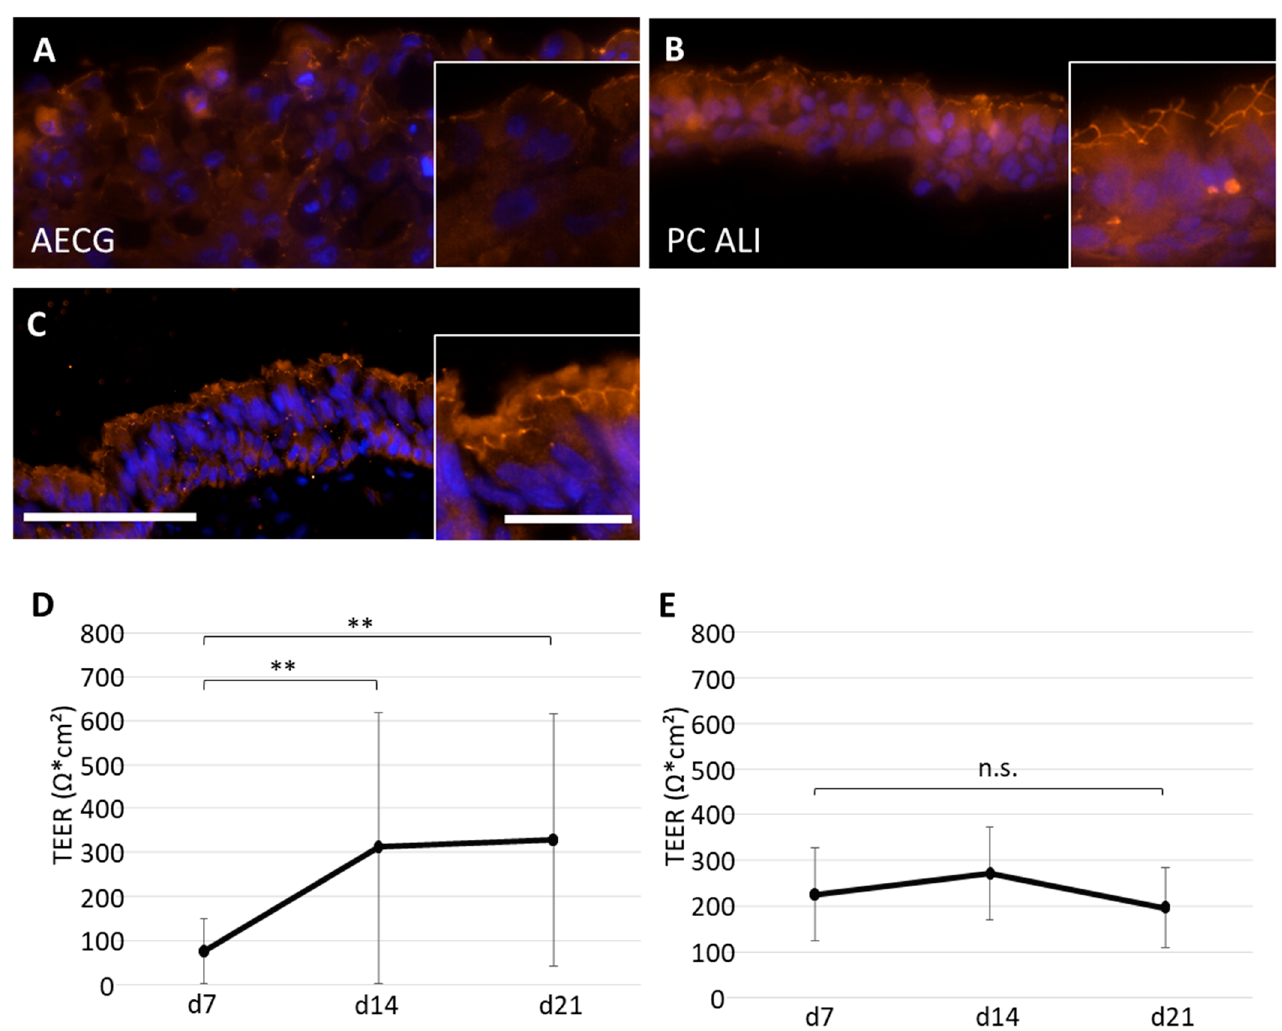
Figure 6. Formation of tight junctions and transepithelial electrical resistance (TEER) measurements in 3D airway tissue models. ( A – C ) Immunofluorescence stainings against zonula occludens (ZO-1, orange) on cross sections of 21 days old ALI models cultivated with AECG (n = 9 from four donors) ( A ) and PC ALI medium (n = 6 from four donors) ( B ), and of native bronchus (control) ( C ). TEER values of airway models cultivated for 7, 14, and 21 days, respectively, as ALI culture in AECG ( D ) and PC ALI medium ( E ) from four donors (d7: PC ALI n = 23, AECG n = 33; d14: PC ALI n = 17, AECG n = 33; d21: PC ALI n = 9, AECG n = 20). Scale bar: 200 µ m, inserts: 100 µ m. Nuclei were stained with DAPI (blue). Shown are the mean average with standard deviation. ** p < 0.001, n.s.: not